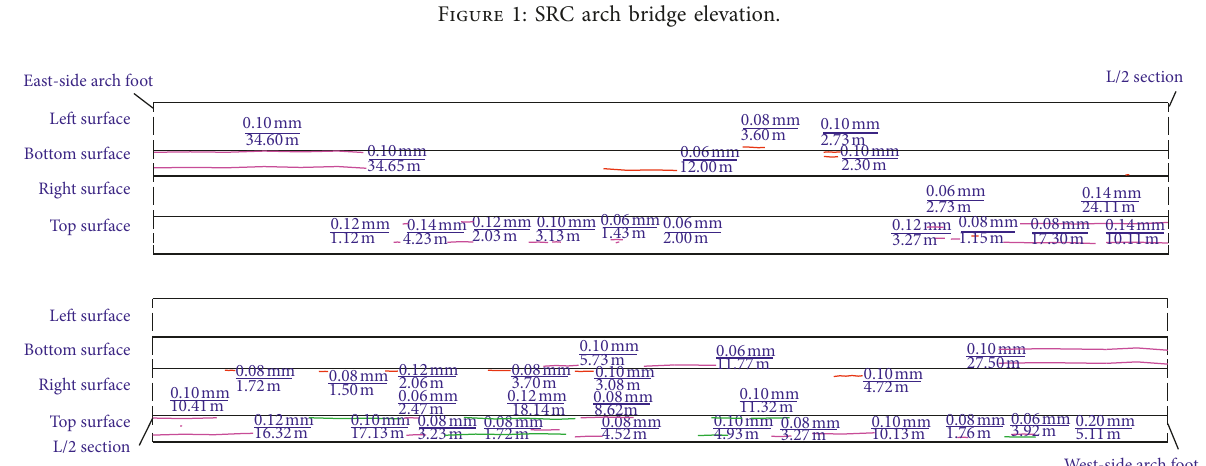
Figure 2: Crack distribution outside #1 arch rib.